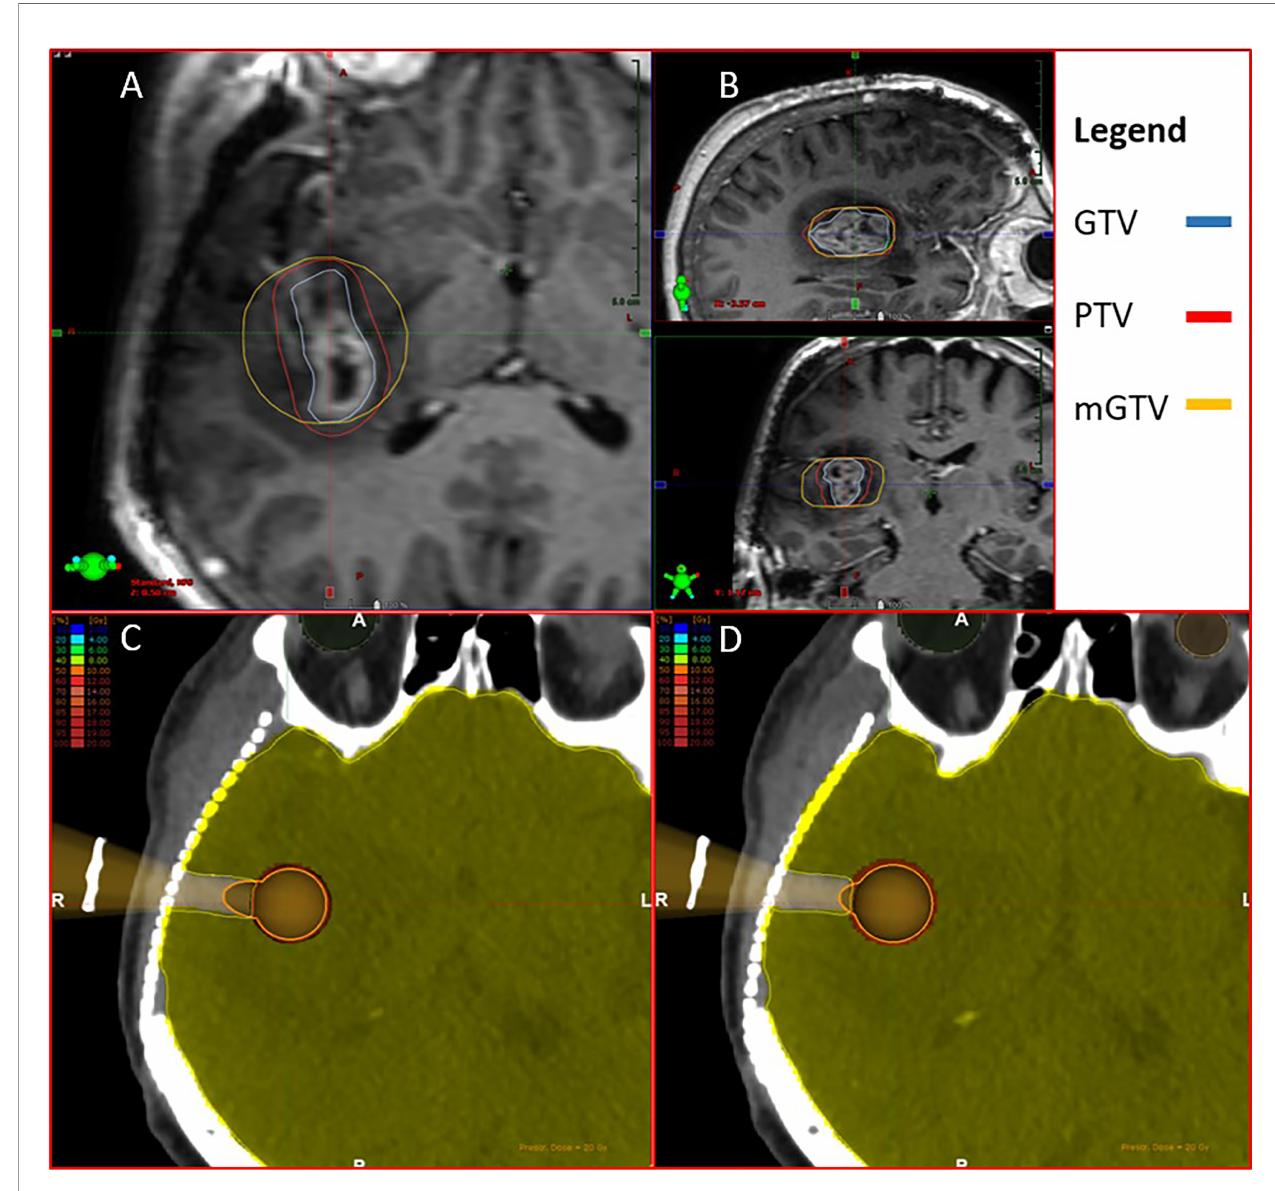
FIGURE 1 | (A, B) Generated contours for intraoperative radiotherapy (IORT) and stereotactic radiosurgery (SRS) boosting. GTV: gross target volume, PTV: planning target volume, mGTV: modi fi ed gross target volume. mGTV was adjusted to fi t the immediate larger apposite applicator. (C, D) Simulated path for the applicator placement. The healthy brain contour was removed from the hypothetical surgical